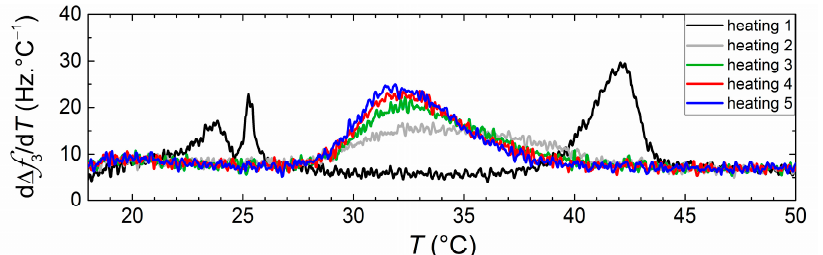
Figure 7. d ∆ f 3 /d T curves obtained upon successive heatings of the DPPC and DPPC vesicle disper- sions incubated for 24 h at T = 16° C.